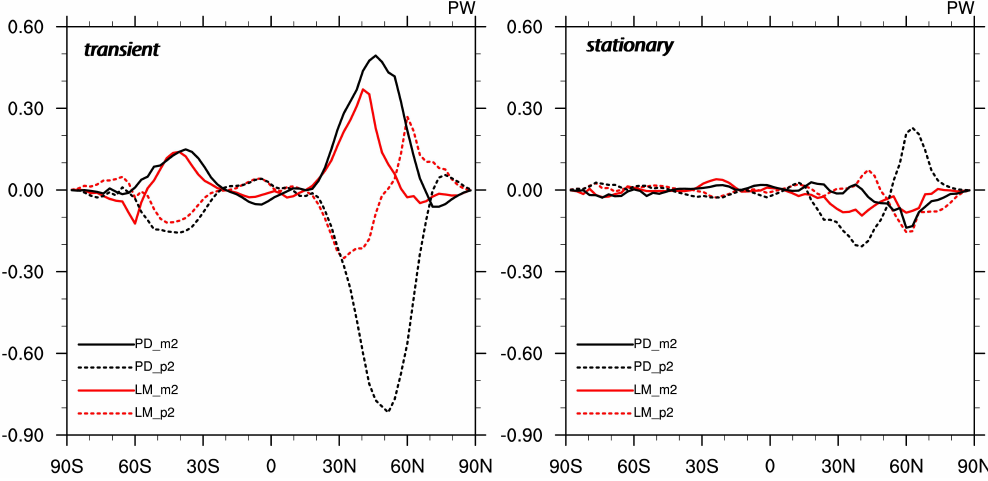
Fig. 7. Vertically integrated transient (left panel) and stationary (right panel) annual eddy heat transport anomalies for PD (black) and LGM (red)